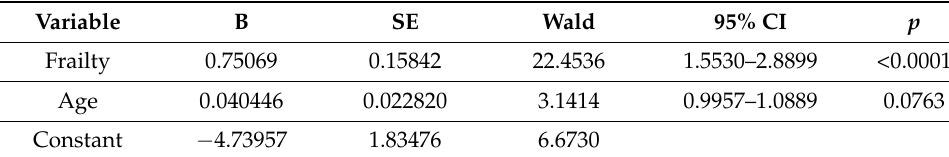
Table 2. Detailed results of logistic regression—female subgroup.